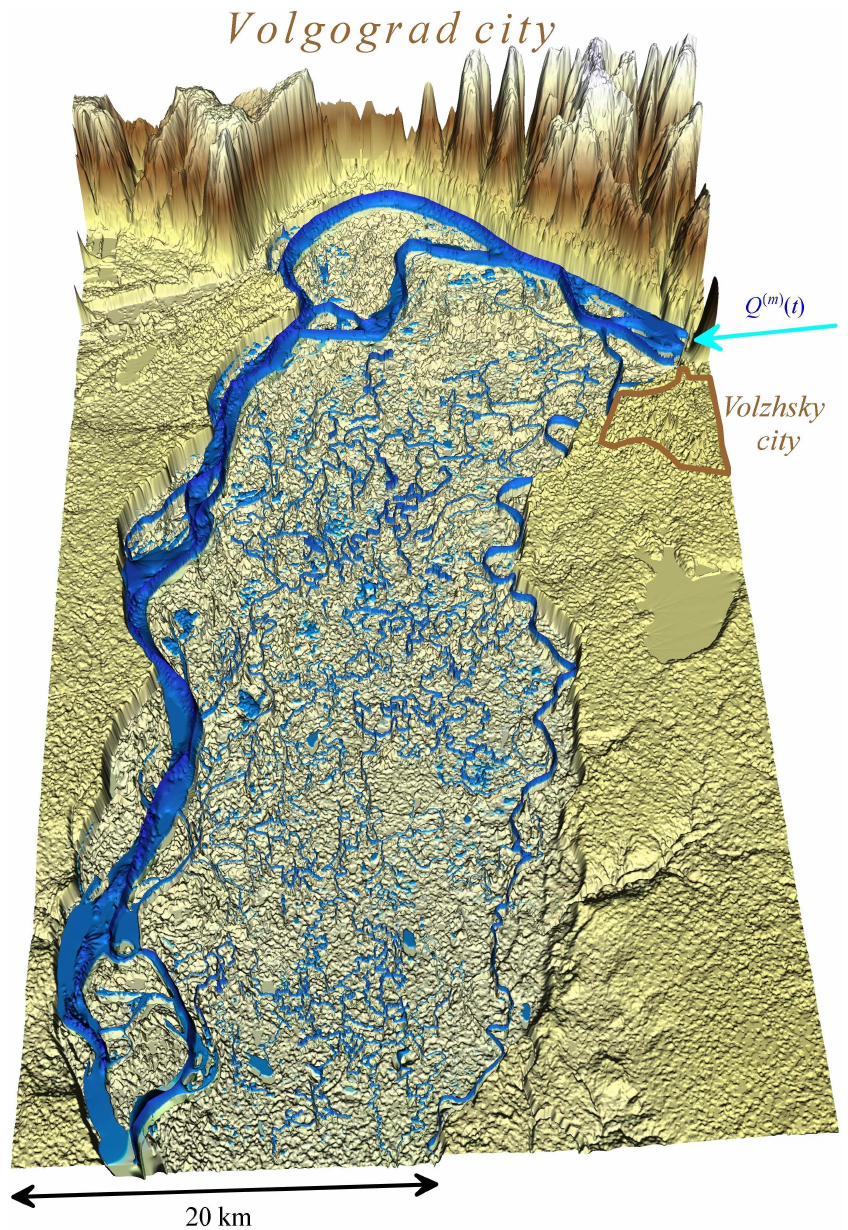
Figure 5. DEM of the northern part of the Volga-Akhtuba floodplain and its environs. The vertical scale differs from the plane-scale (the elevation level within the Volgograd city boundary is 50 ÷ 100m higher compared to the floodplain area). The blue color shows the water distribution from our numerical